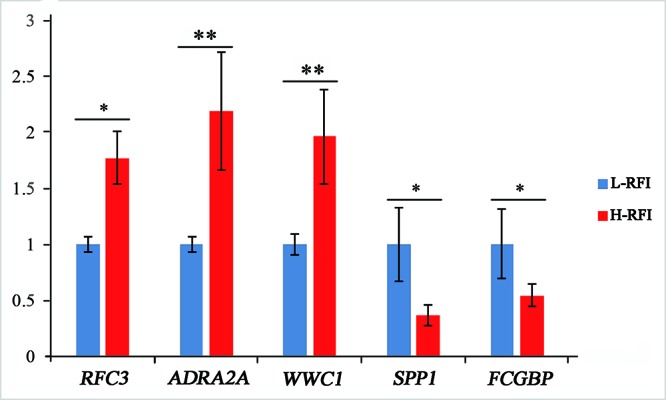
Validation of differentially expressed genes (DEGs) using quantitative real-time reverse transcription PCR (qRT-PCR). The qRT-PCR measurements of the expression of RFC3, ADRA2A, WWC1, SPP1, and FCGBP mRNA transcripts were analyzed using the ΔΔCt method; *significant difference between the high-RFI and low-RFI groups (P < 0.05), **very significant difference between the high-RFI and low-RFI groups (P < 0.01).